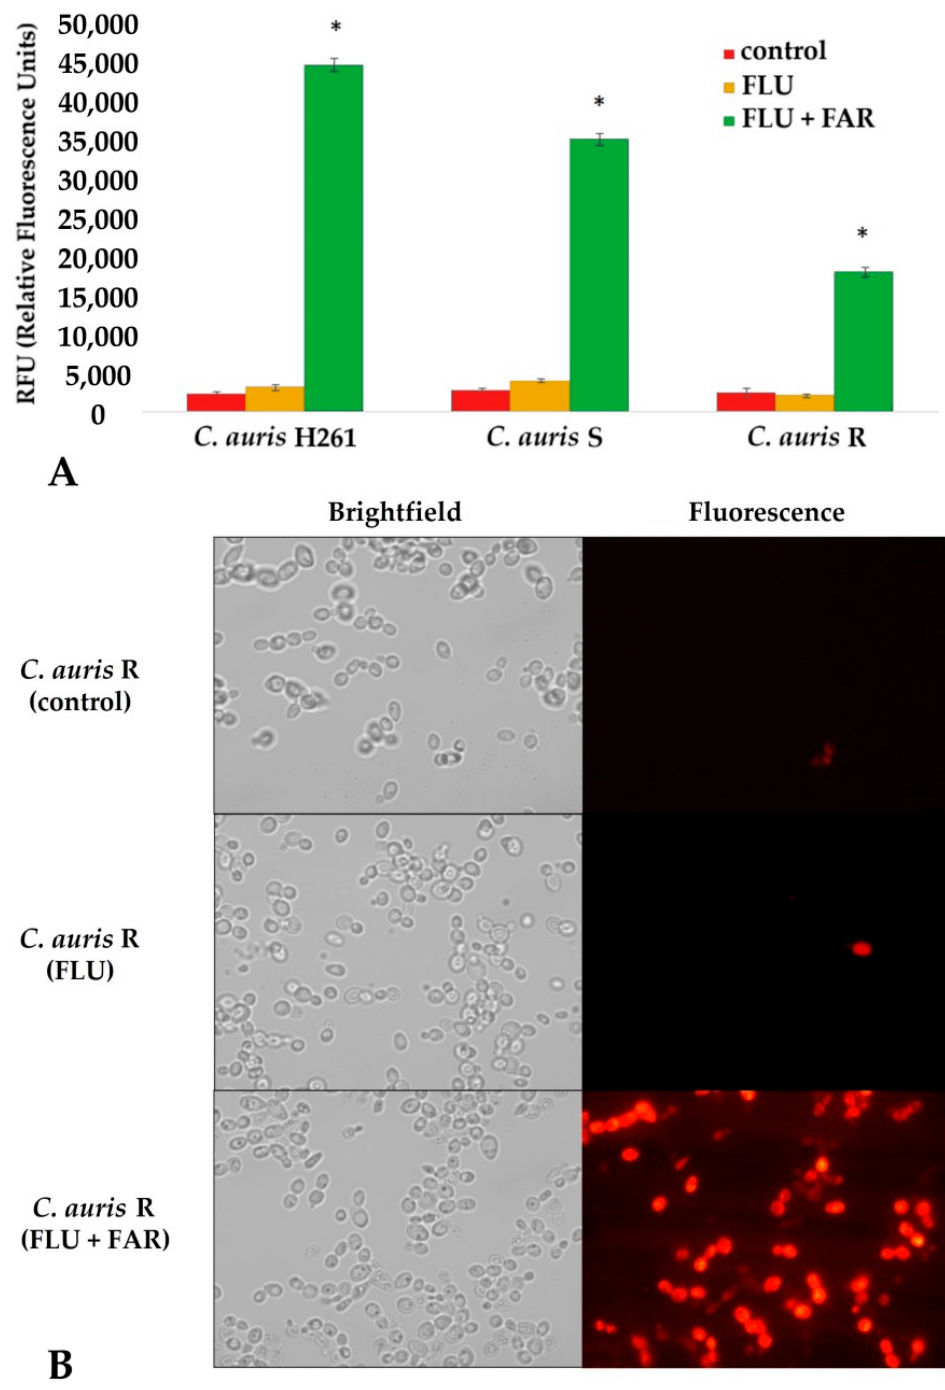
Figure 5. ( A ) Rhodamine 6G intracellular accumulation measured by relative fluorescence. The figure shows a significant increase in the accumulation of R6G dye in all C. auris treated with a combination of FAR and FLU resulting in the highest abundance of fluorescence (green columns). The cells treated only with the subinhibitory concentration of FLU (yellow columns) have the same level of R6G as control cells without any agent (red columns) which means that R6G was extruded from cells by efflux. Subinhibitory concentrations of FLU were as follows: 0.06 μ g/mL for C. auris H261, 8 μ g/mL for C. auris S, and 32 μ g/mL for C. auris R. ( B ) Fluorescence microscopy of the selected yeast suspension of the most resistant isolate C. auris R confirms the highest accumulation of R6G in the cells after a combination of FAR and FLU, confirming FAR as an inhibitor of efflux pump Cdr1; p -values * < 0.05 were considered significant.